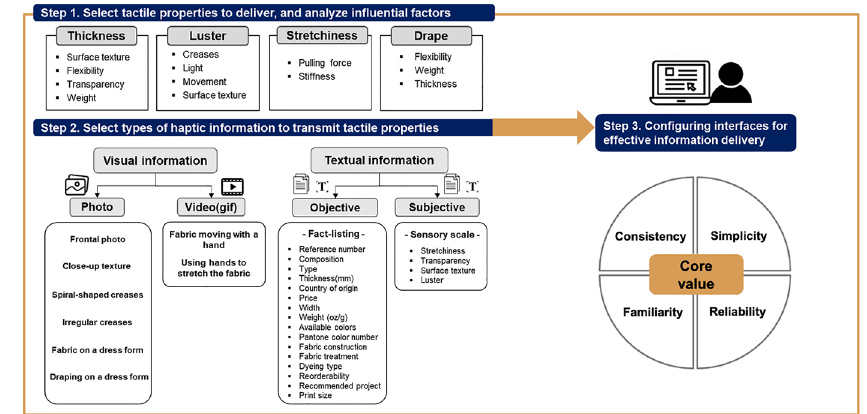
Fig. 5 Conceptual framework for fabric presentation in digital